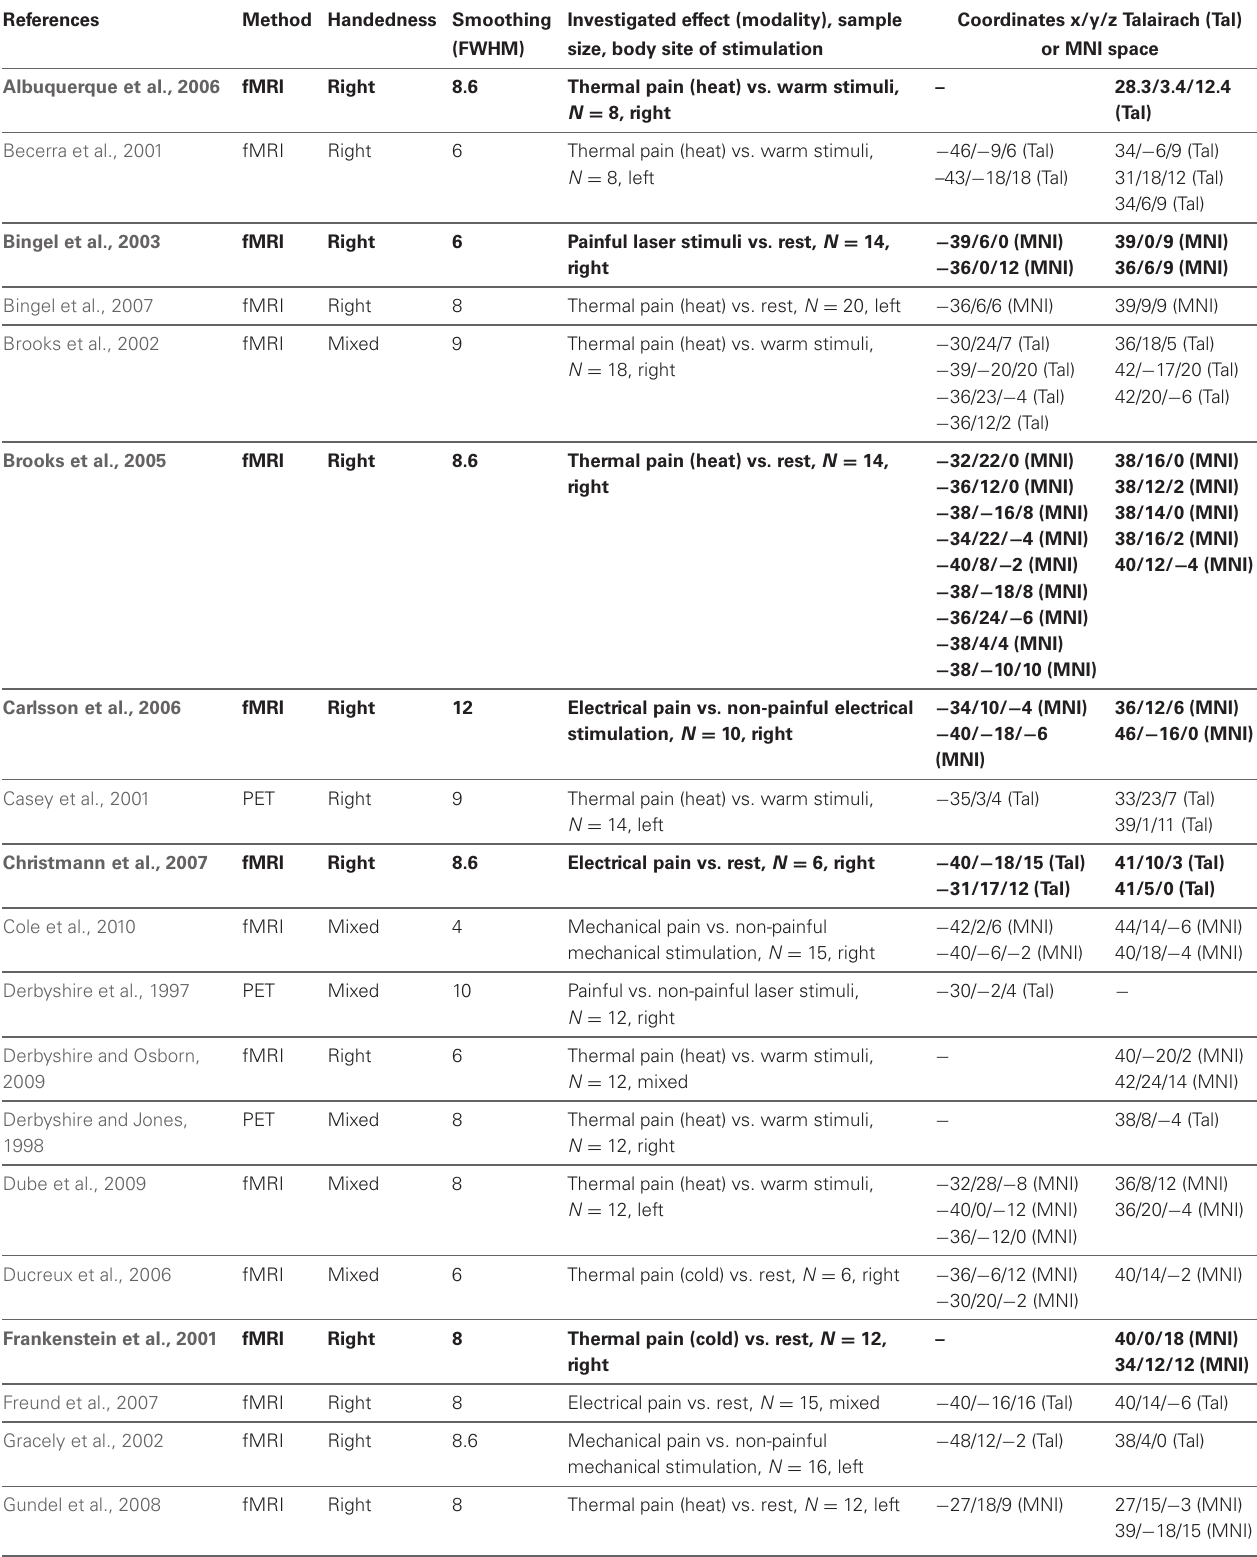
Table B | Fifty-seven neuroimaging studies investigating pain in healthy subjects entered the ALE